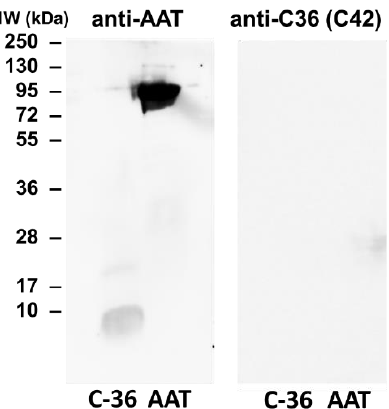
Figure 3. A full-length AAT protein and C-36 peptide separated by 16.5% SDS-PAGE gels, followed by Western blotting using polyclonal rabbit anti-human AAT (anti-AAT) and mouse monoclonal anti-C-36 peptide antibody (C42). Protein samples prepared for SDS-PAGE analysis were denatured by heating at 90  C for 3 min. After electrophoretic separation, proteins were transferred into 0.2µm polyvinylidene difluoride (PVDF) membranes. Membranes were blocked for 1 h with TBS+ 0.01% Tween-20 containing 5% low fat milk powder and incubated overnight at 4 °C with rabbit polyclonal anti-human AAT (1:800) or C42 mAb (1:500). The immune complexes were visualized with appro- priate horseradish peroxidase-conjugated secondary antibodies and enhanced by ECL Western blotting substrate. Images obtained with Chemidoc Touch imaging